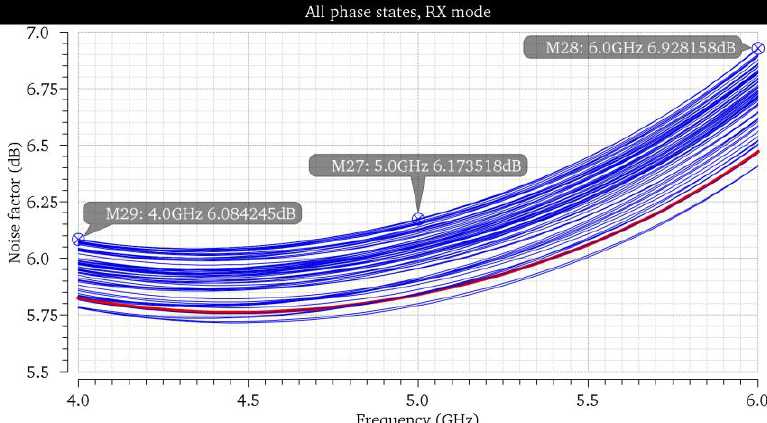
Fig. 7. Dependence of the noise figure in Rx mode from